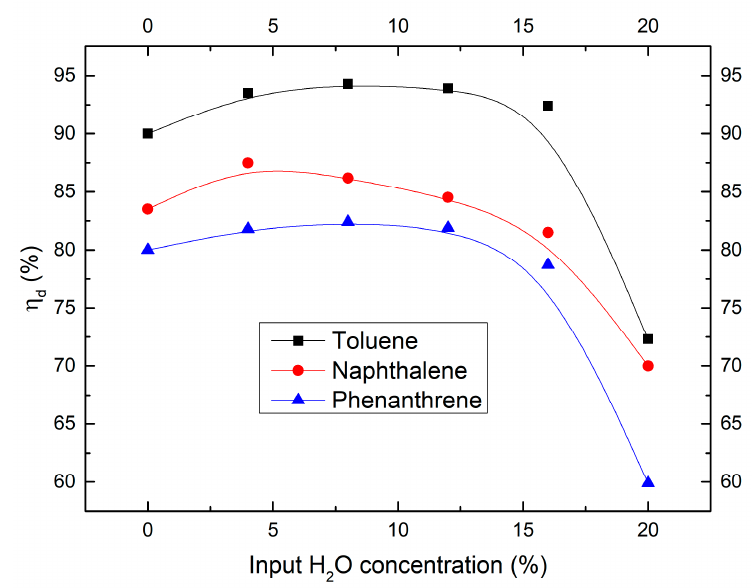
Figure 5. Effect of moisture concentration on destruction Figure5. Effect of moisture concentration on destruction efficiency.